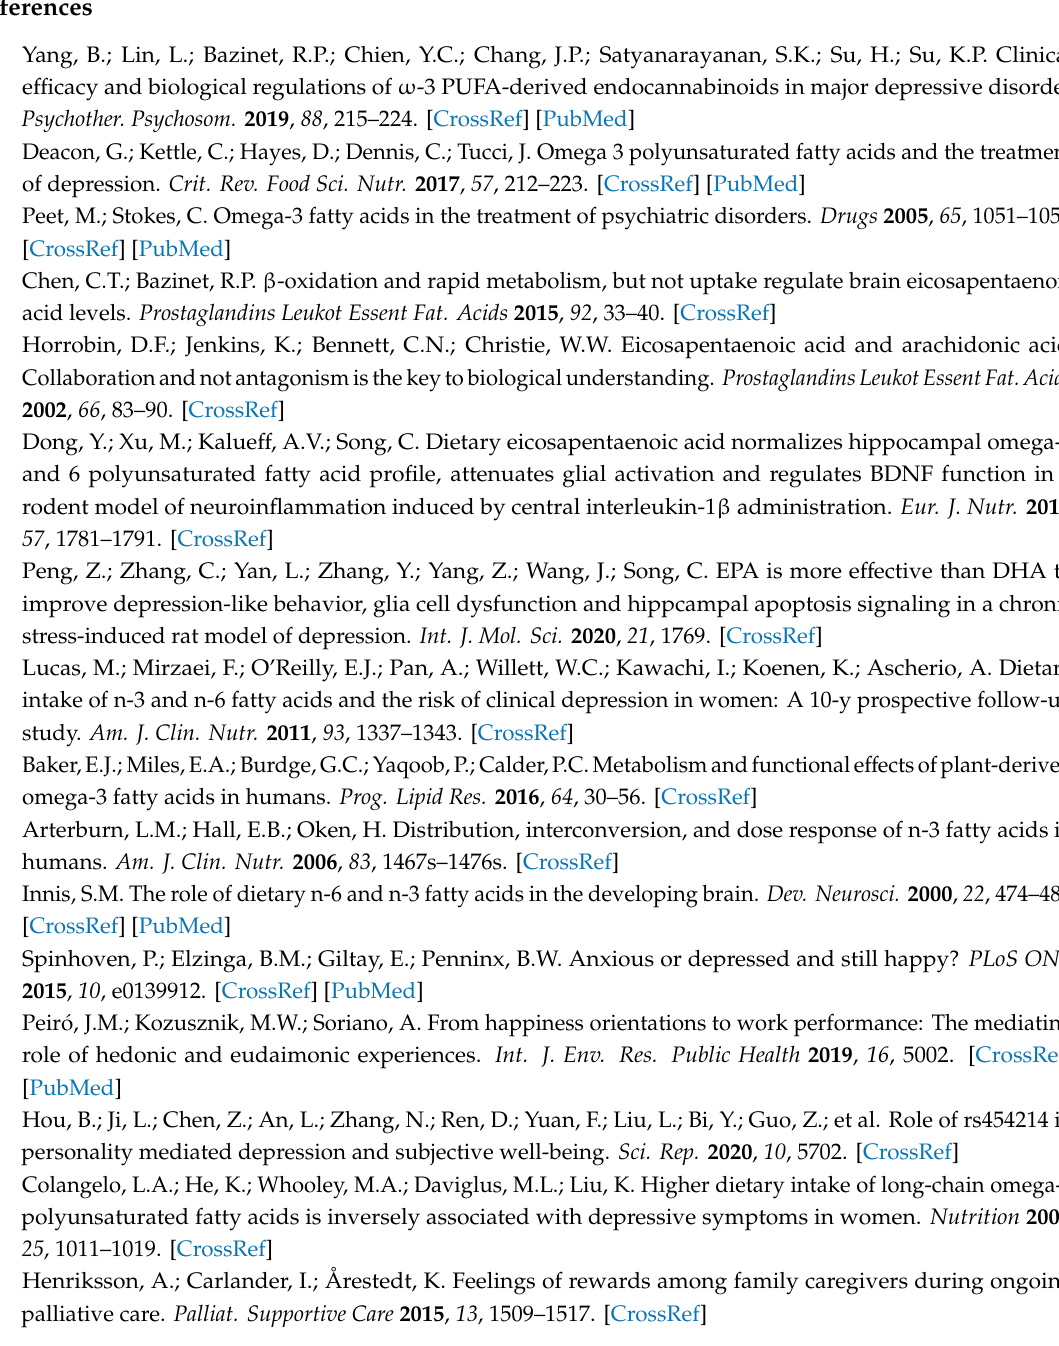
Table S1: Di ff erences of PUFA% by physical, social and lifestyle